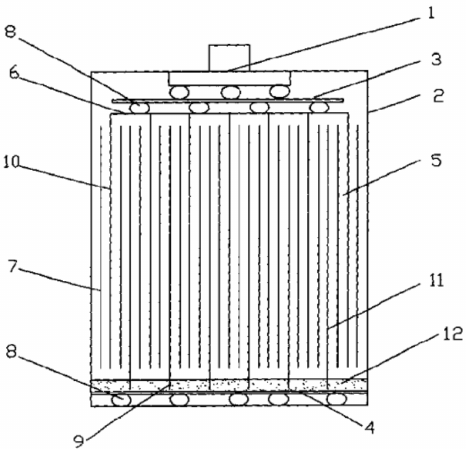
Figure 12. Schematic diagram of a high-power cell with 1: vent cap, 2: cell case, 3: current collector plate, 4: negative electrode plate, 5: electrode assembly, 6: positive electrode plate, 7: separator, 8: spot welding, 9: negative electrode, 10: positive electrode, 11: wound negative electrode, and 12: metallic foam [150].